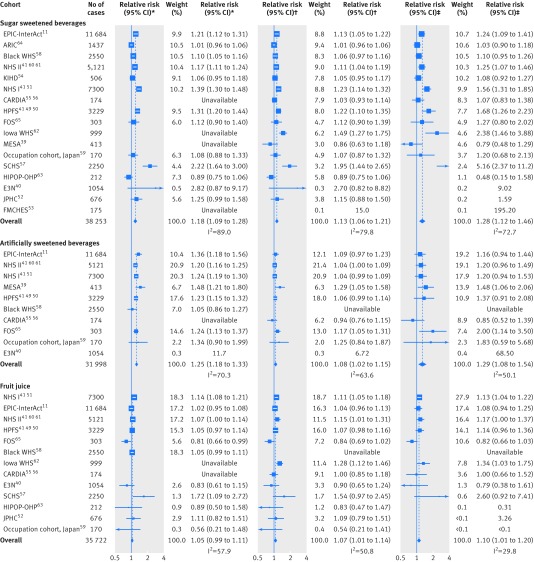
Fig 1 Prospective associations of beverage consumption with incident type 2 diabetes: random effects meta-analysis. *Unadjusted for adiposity. †Adjusted for adiposity. ‡Adjusted for adiposity and within person variation. Cohorts were ordered by weights in the most adjusted model. Estimates with 95% confidence intervals greater than 10 are not presented. Supplementary table S4 summarises the covariates adjusted for in each study